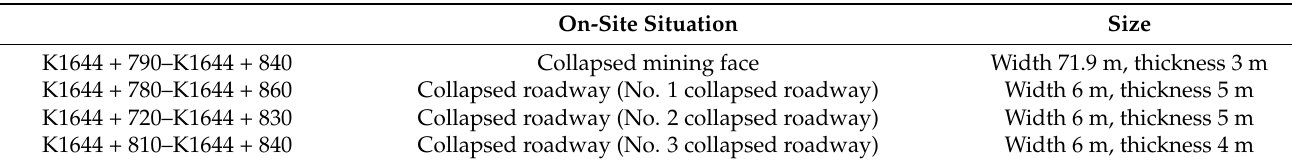
Table 1. State of goaf collapsed areas.